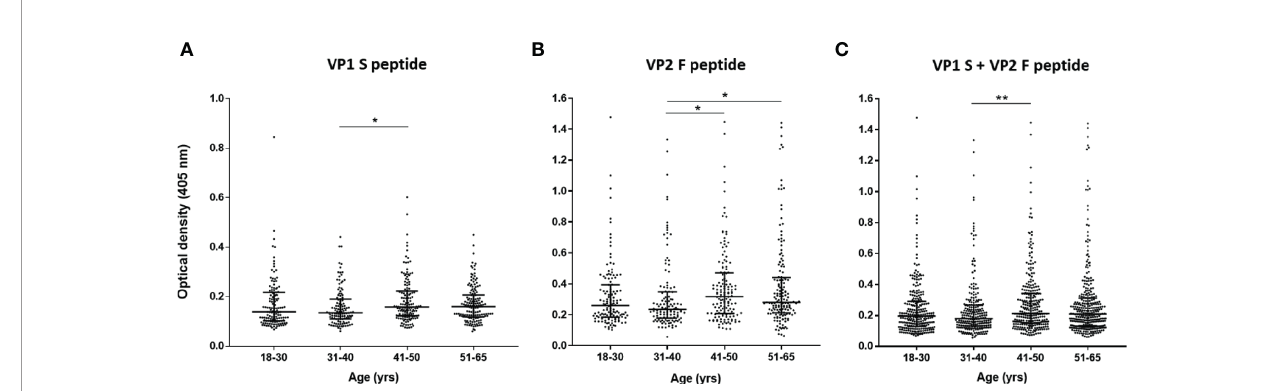
FIGURE 4 | Serologic pro fi les of serum antibody reactivity to MCPyV peptides in age-strati fi ed healthy subjects (HS). Analyses were performed with VP1 S (A) , VP2 F (B) peptides and for combined VP1 S and VP2 F (C) in healthy subjects (HS). Immunologic data are from age-strati fi ed HS (n=548) and results are presented as optical density (OD) value readings at l 405nm for serum samples assayed in indirect ELISA. In the scatter dot plot, each dot represents the dispersion of ODs for each sample. The median is indicated by the line inside the scatter plot with the interquartile range (IQR) in age-strati fi ed HS, i.e., 18-30 yrs (n=130), 31-40 yrs